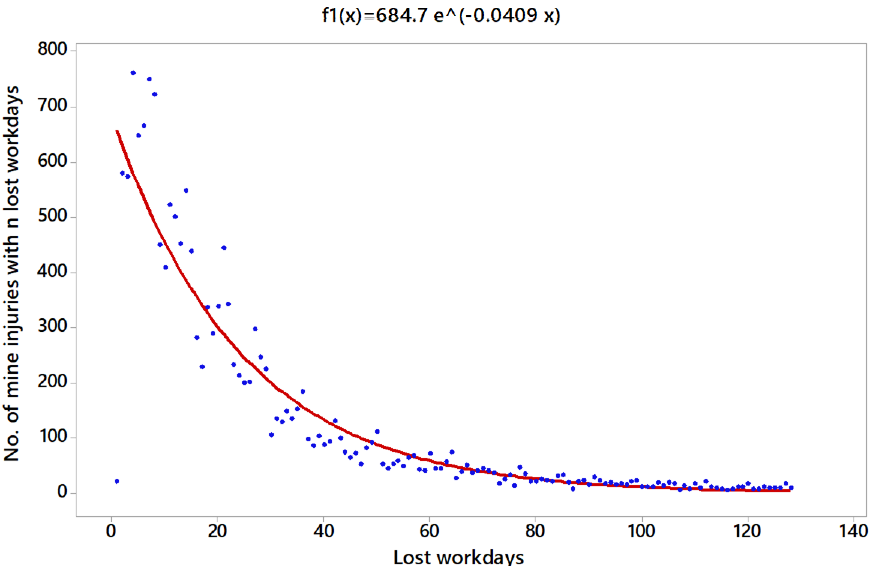
Figure 4. Regression model for the number of UG injuries.